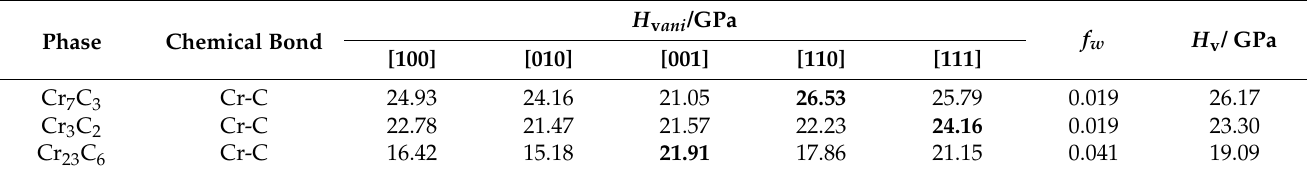
Table 5. The calculated anisotropic hardness of binary chromium